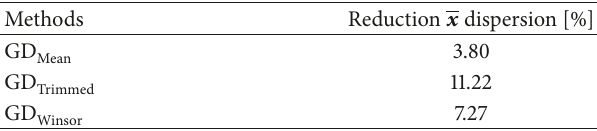
Table 39: Exponential with 50 points.